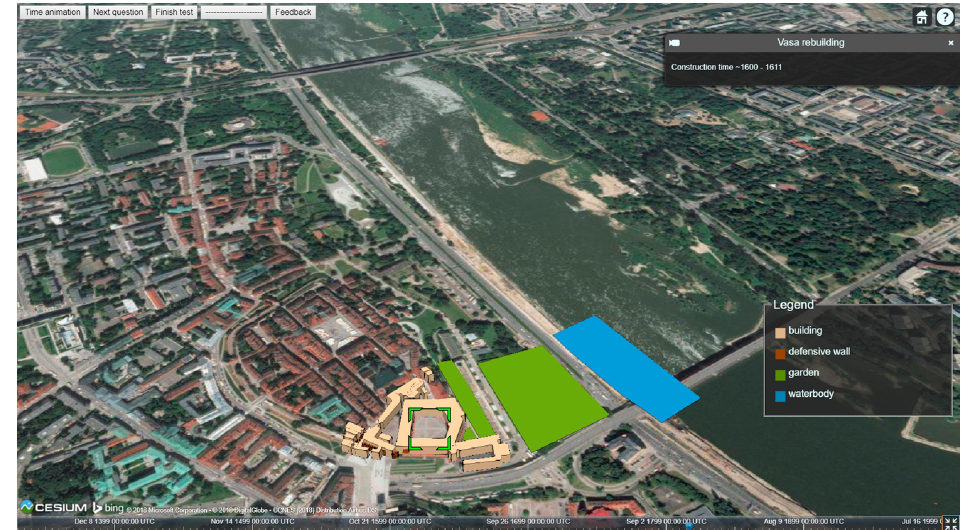
Figure 4. Interface of the slider-based spatiotemporal visualization of the Royal Castle in Warsaw.